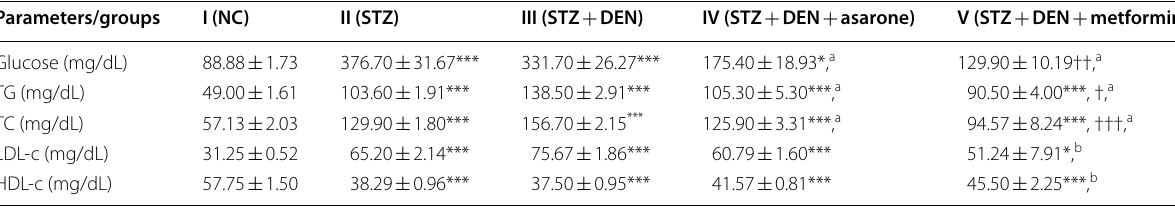
Table 2 Effect of asarone and metformin on various blood serum parameters